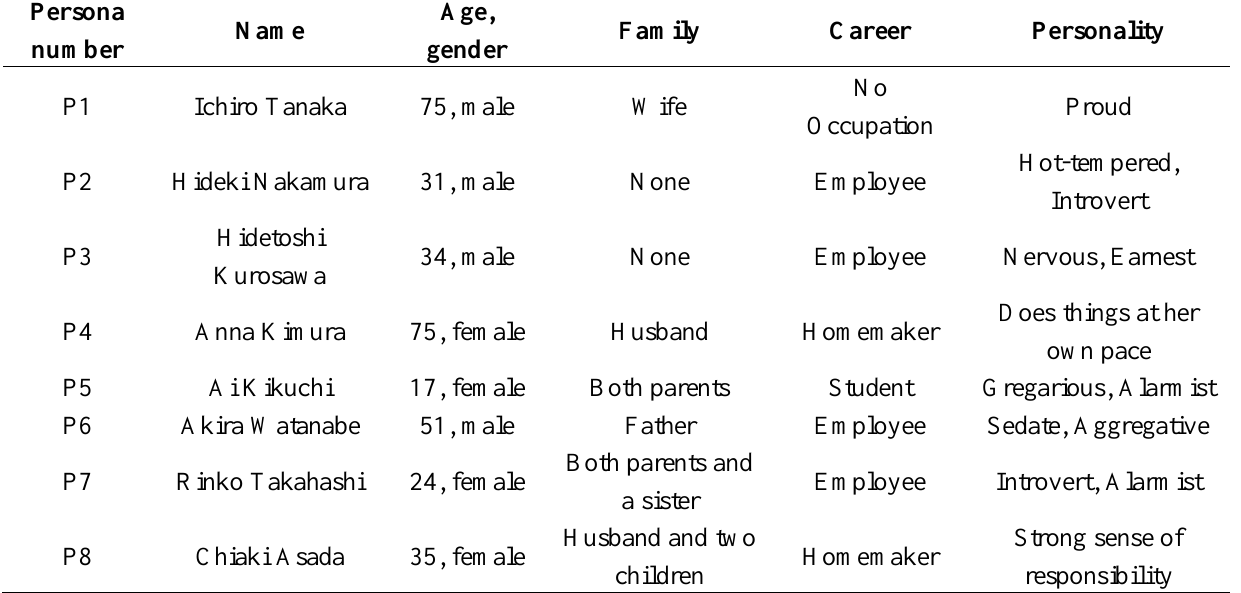
Table 2. Demographic and psychological data of each